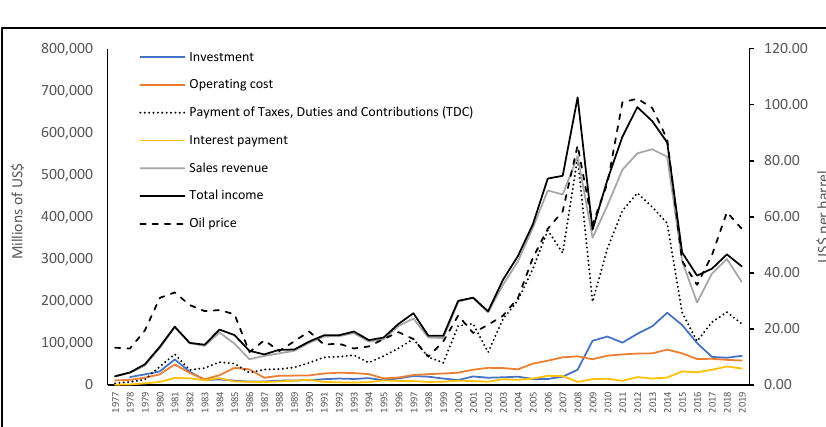
Table 1. Indicators from Pemex ’ s financial balance and average